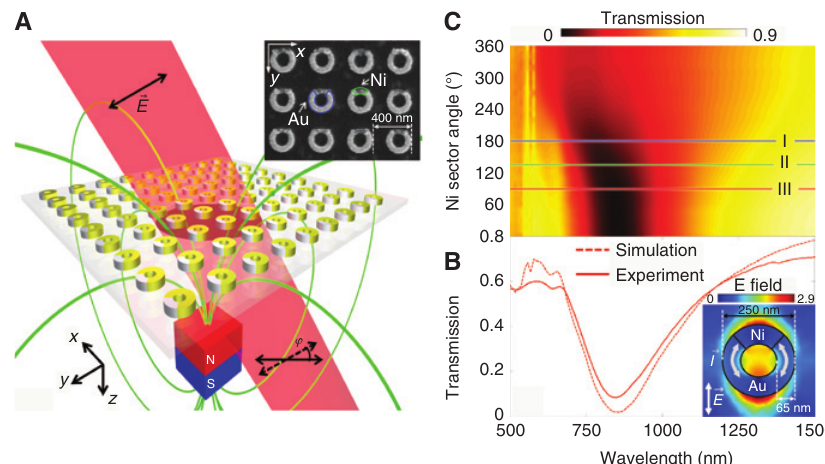
Figure 1: Linear optical properties of bimetallic ring resonator arrays. (A) Schematic of a bimetallic metamaterial array. In the presence of an external magnetic field (represented by the green lines), the meta- material induces rotation of the polarization azimuth angle, ϕ , on the incident beam. The inset is a scanning electron microscope (SEM) image of a fabricated sample. (B) Characteristic transmission spectra of a metamaterial sample with Ni sector that spans 90 ° illuminated with light polarized in the symmetry plane of the ring. Similar resonant behavior is observed for the orthogonal polarization (see Figure 1 of Supplementary Material). The dashed line is obtained by a computational analysis of an infinite 2D array, while the solid line cor- responds to the experimentally measured spectra of a 100 × 100 μ m 2 metamaterial sample. Inset: Electric field distribution in the vicinity of the bimetallic ring at resonance ( λ = 850 nm). (C) Transmittance of regular arrays consisting of bimetallic rings with Ni sector varying from 0 ° to 360 ° , calculated numerically. The three colored lines correspond to different fabricated samples (90 ° – red/III, 135 ° – green/II and 180 ° –